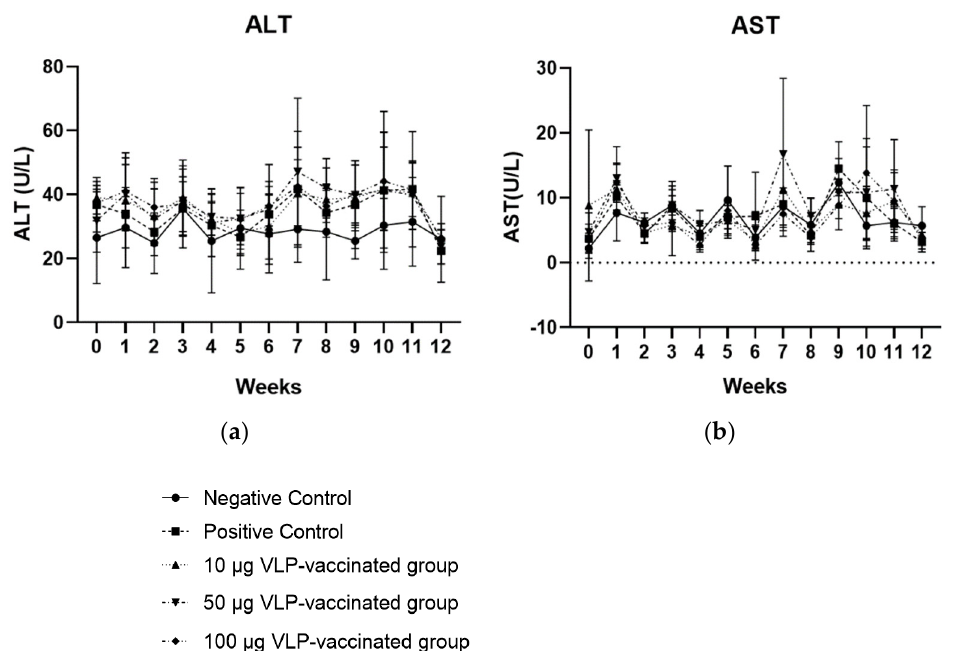
Figure 2. Serum ALT ( a ) and AST ( b ) levels of the rabbits each week. Serum ALT and AST levels of rabbits in the three vaccinated and positive control groups showed no statistical difference compared to those of rabbits in the negative control group.